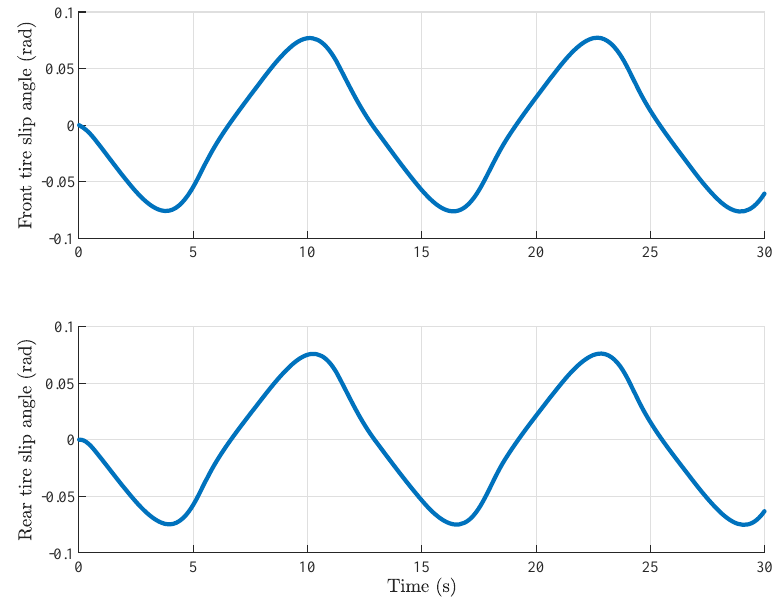
Figure 18. Evolution of slip angle of EDMD-MPC (Case 3). RMSM of the proposed DMDc-MPC and EDMD-MPC in different cases is shown in Table 5. The accuracy of the Koopman linear model based on the EDMD algorithm is higher, so the tracking accuracy of EDMD-MPC is slightly higher than that of DMDc-MPC. (cid:114) The simulations are carried out with Processor Intel Core TM i7-10700CPU @2.90 GHz (cid:114) produced by Intel Corporation, Santa Clara, CA, USA, and 16 GB RAM produced by Ra- maxel Technology, Shenzhen, China. The optimization problem is solved by qpOASES [45]. The average computation time of the involved optimization problem is shown in Table 6, which is much smaller than the sampling time 10 ms. Compared with EDMD-MPC, DMDc-MPC can achieve similar performance with smaller computation